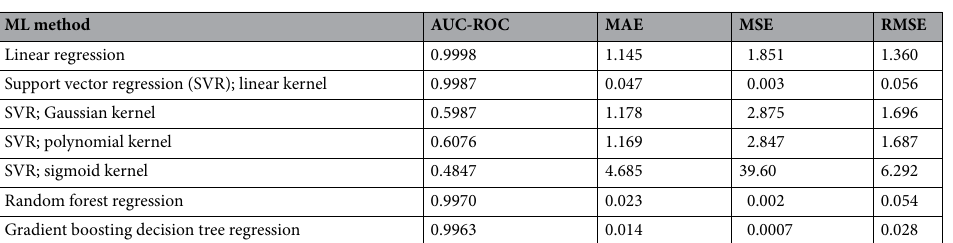
Table 5. The mean absolute error (MAE), mean square error (MSE), root mean square error (RMSE), and area under curve (AUC) of receiver operating characteristics (ROC) of the applied machine learning (ML) regression methods in predicting the oil percentage of the Lallemantia iberica ecotypes with the training of other traits, using the K-fold cross-validation as the data splitting method.